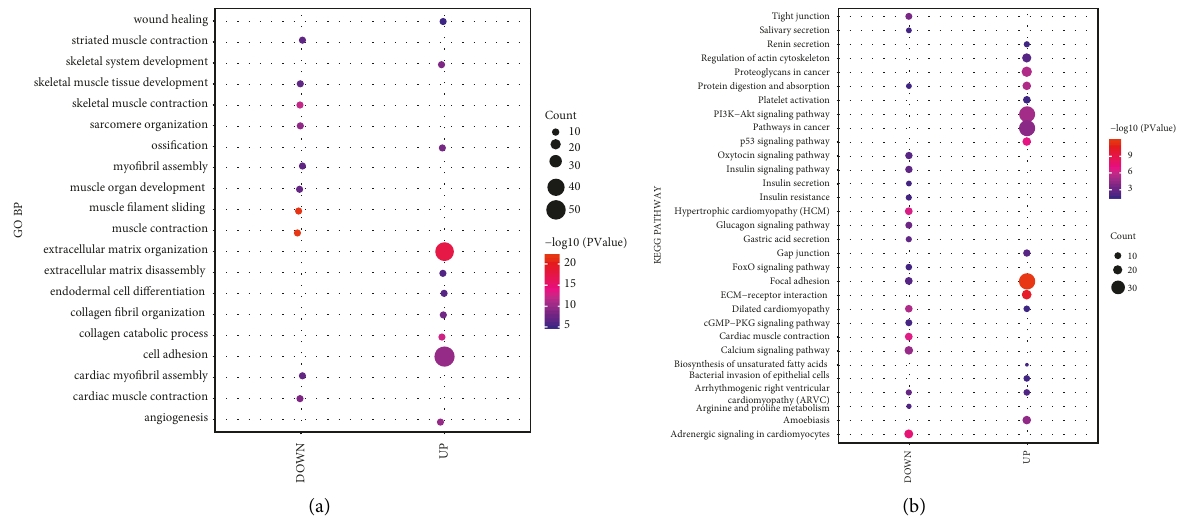
Figure 2: GO BP and KEGG pathway enrichment analyses for DEmRNAs. The top 10 GO BP (a) and KEGG pathway. (b) Enrichment analysis results of upregulated or downregulated DEmRNAs.